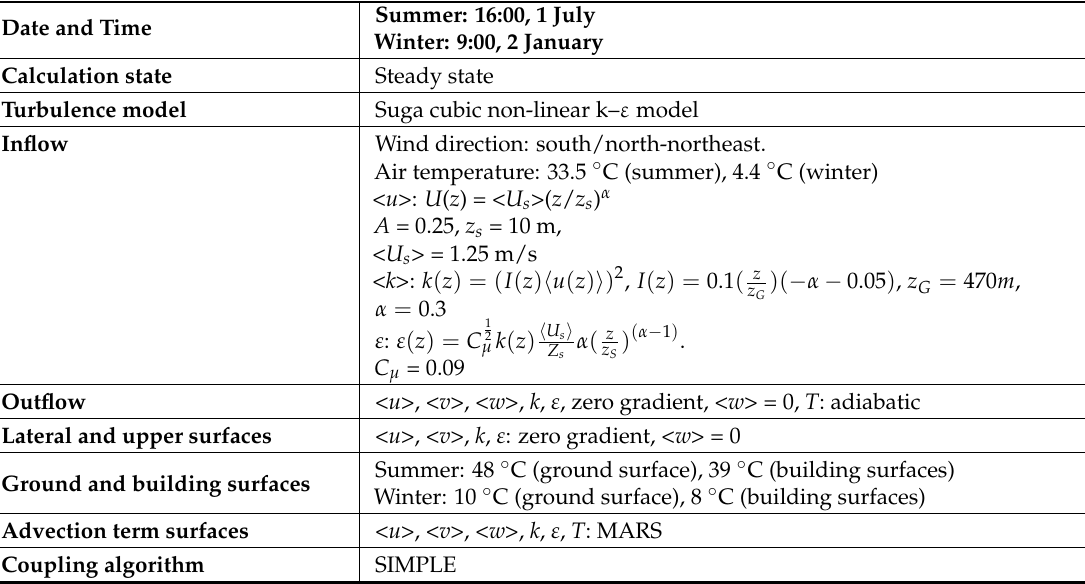
Table 3. The step 1 analysis